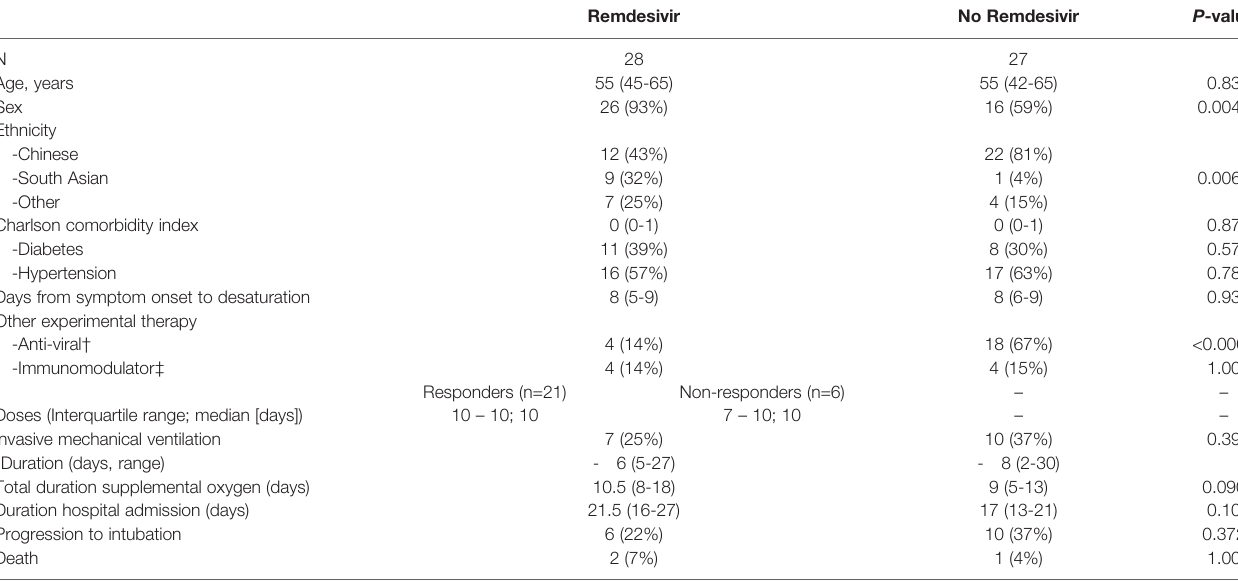
TABLE 1 | Demographics, Presenting Symptoms, Parameters, and Laboratory Investigations Strati fi ed by Remdesivir